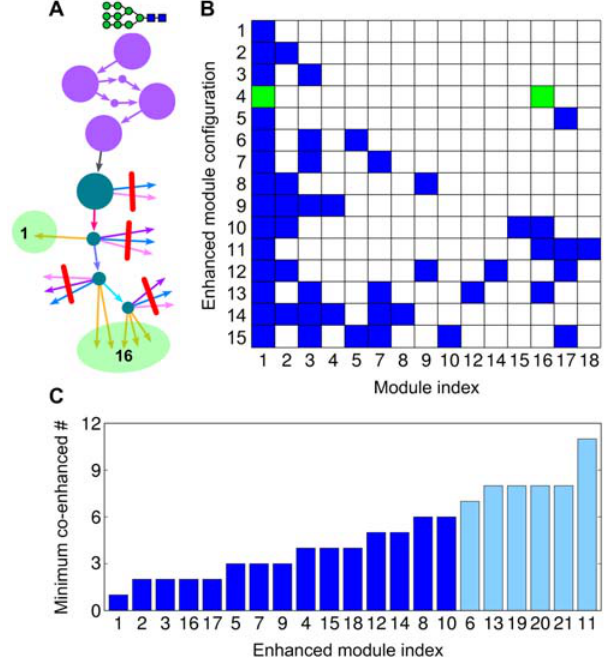
Figure 3. Regulation of glycan synthesis. (A) Enhancement of glycan production in specific modules is illustrated with a part of the pathways in Figure 2(A). The down-regulation of GnTIII, GnTIV, and FucT weakens the reactions crossed by red lines, thus strengthening the other reactions toward the 1st and 16th modules, as highlighted. (B) The modules to be enhanced or suppressed under combinations of enzyme up- and down-regulation. Here we show only the cases where six or fewer modules become enhanced, and exclude the indices of the modules that are never enhanced in these cases. Each row displays a unique pattern of module enhancement resulting from certain regulatory combinations, and is labelled as shown in Table S1. Enhanced modules are colored blue or green, and suppressed ones are indicated in white. The row including greens is for the case demonstrated in (A). (C) From the lists of modules to be enhanced together with a given module on the horizontal axis, we enumerated the minimum number of such co-enhanced modules as shown in the vertical axis. Blue is for less than or equal to 6 in the minimum number, obtained from the module enhancement pattern shown in (B).